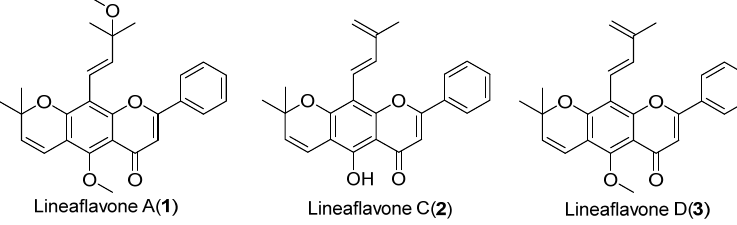
Figure 1. The structure of lineaflavone A, lineaflavone C and lineaflavone D.